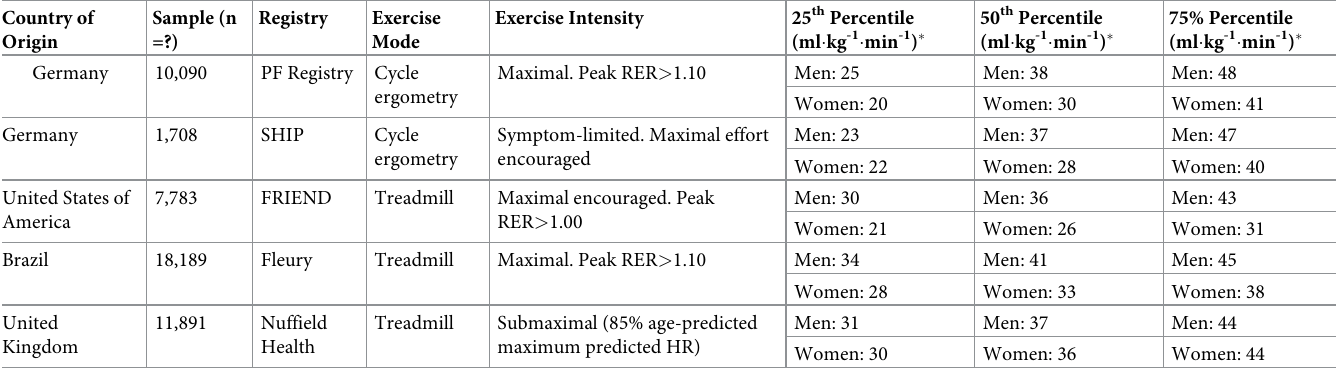
� Estimated values derived from available data. Percentile ranges based on a 45-year-old male/female in the 25 th , 50 th and 75% percentile range for directly determined and estimated cardiorespiratory fitness using either a treadmill or cycle ergometer test